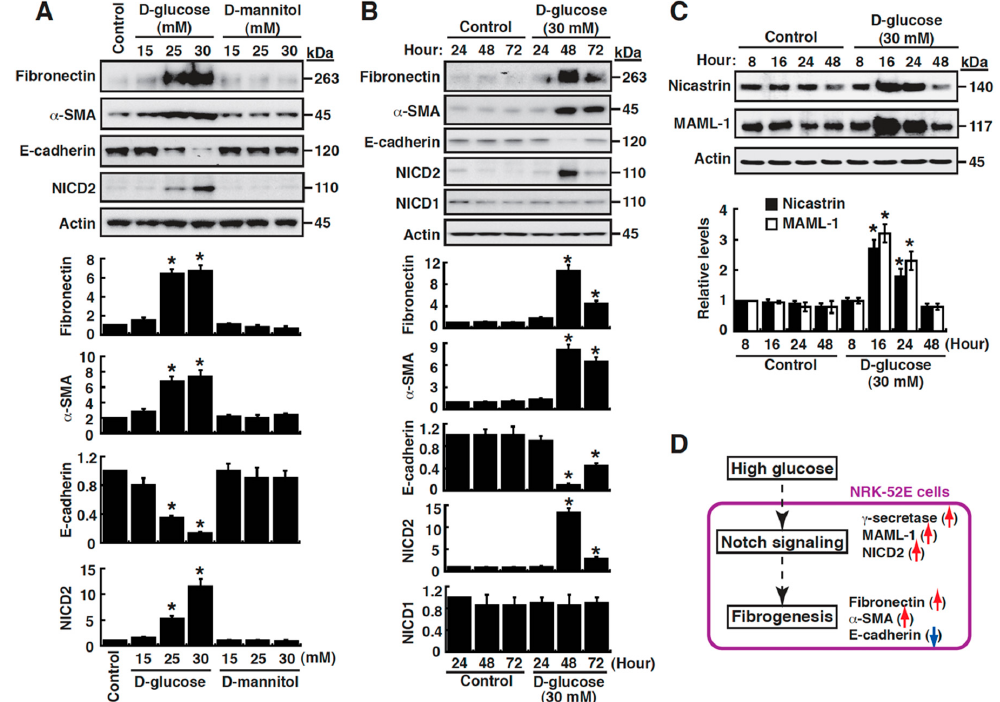
Figure 1. High glucose induces EMT (epithelial-mesenchymal transition) and Notch2 activation in renal tubular epithelial cells. ( A ) Effect of high glucose concentrations on the expression of EMT markers (including fibronectin, alpha-smooth muscle actin ( α -SMA) and E-cadherin) and cleaved